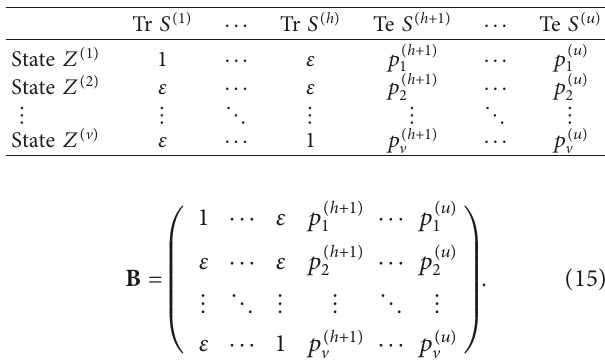
Table 3: Bearing state score table.